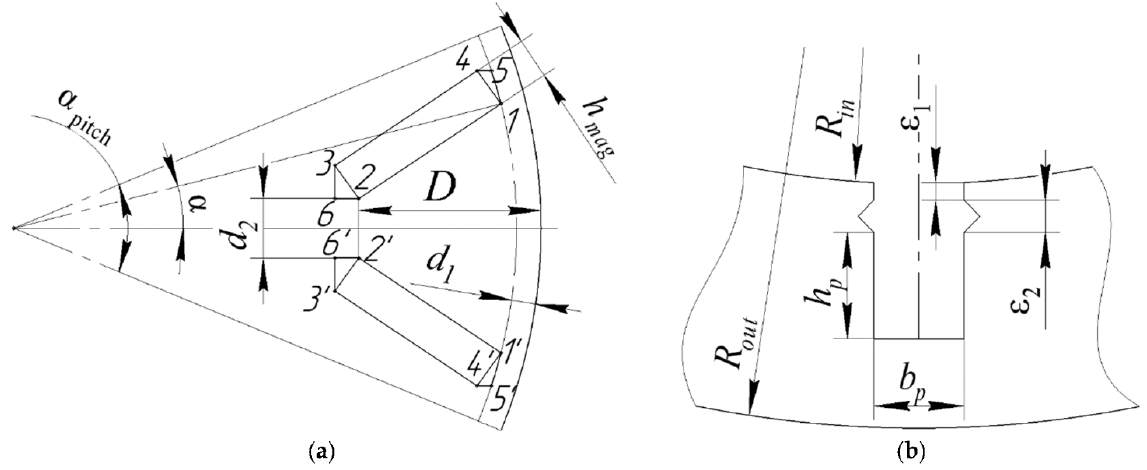
Figure 5. Parameters of the IPMSM: ( a ) rotor; ( b ) stator.